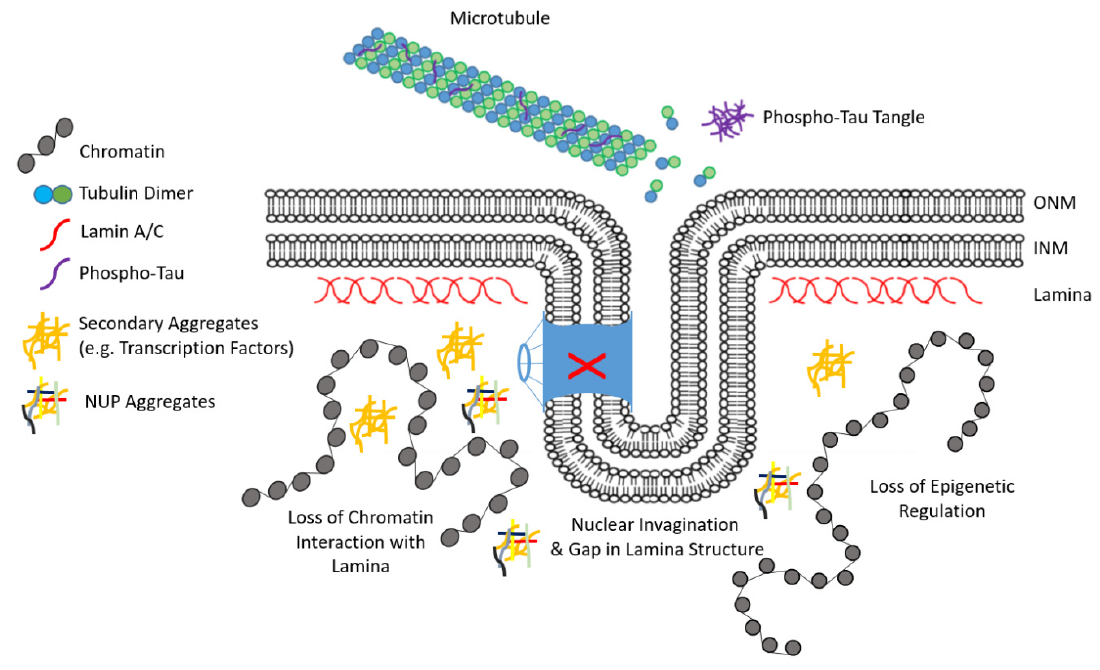
Figure 4. Schematic representation of lamina deformation in neurodegenerative diseases (NDs). Aggregates of proteins, such as phospho-Tau (purple lines) lead to the disruption of nuclear pore complexes (blue structure) and loss of nucleo–cytoplasmic transport (red X). This loss of transport leads to accumulations of nuclear proteins (orange lines) and nuclear pore proteins (NUPs—multicolored lines). The accumulation of these aggregates further disrupts the nuclear lamina, facilitates invagination of the nuclear membranes and, ultimately, the loss of heterochromatin (gray spheres).